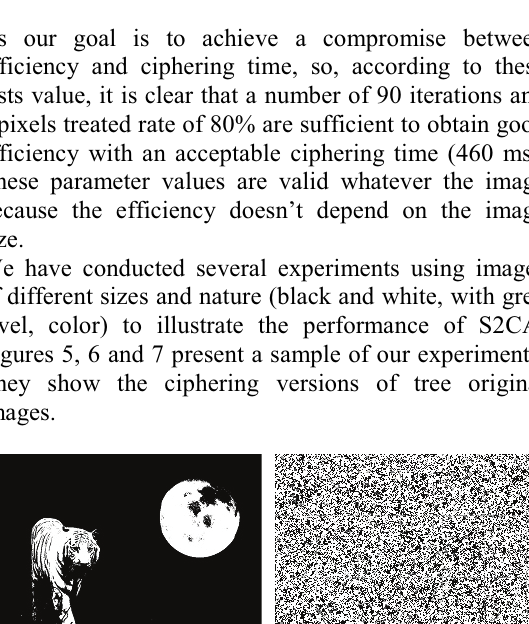
Fig. 5. (a) I1-Model image 1 (300 × 187), (b) Ciphered image of the model image1.